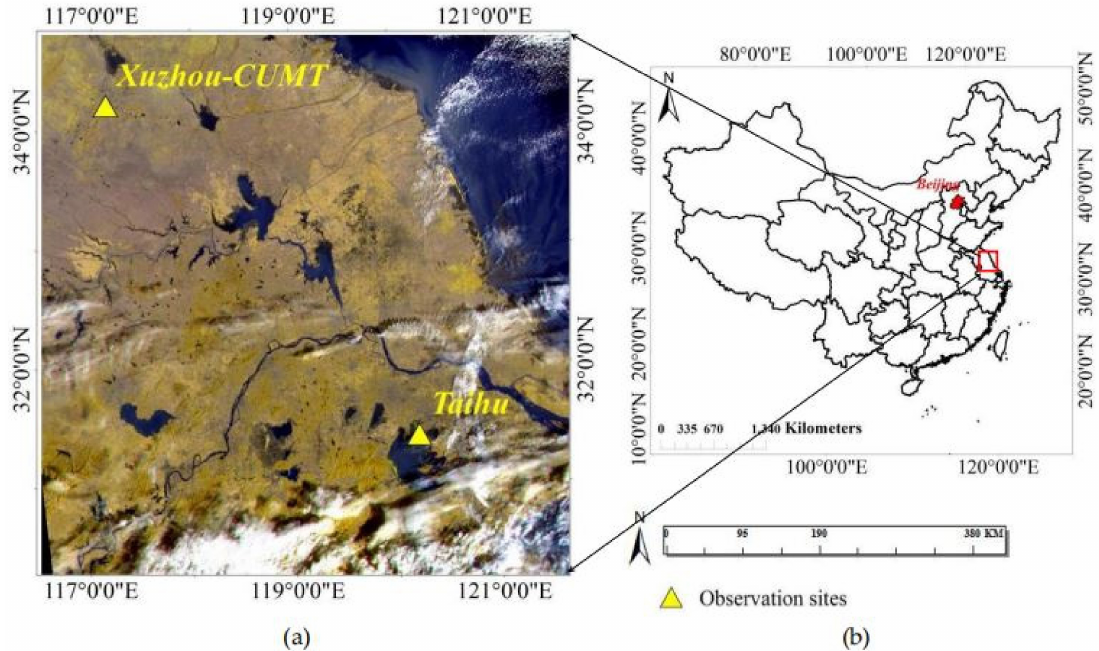
Figure 4. Remote sensing image of the study area (The study selected images taken at 8:30 a.m. on 6 November 2017, and the color image is a composite image of GOCI bands 8, 7 and 6); ( a ) GOCI remote sensing image, ( b ) The location of the study area in